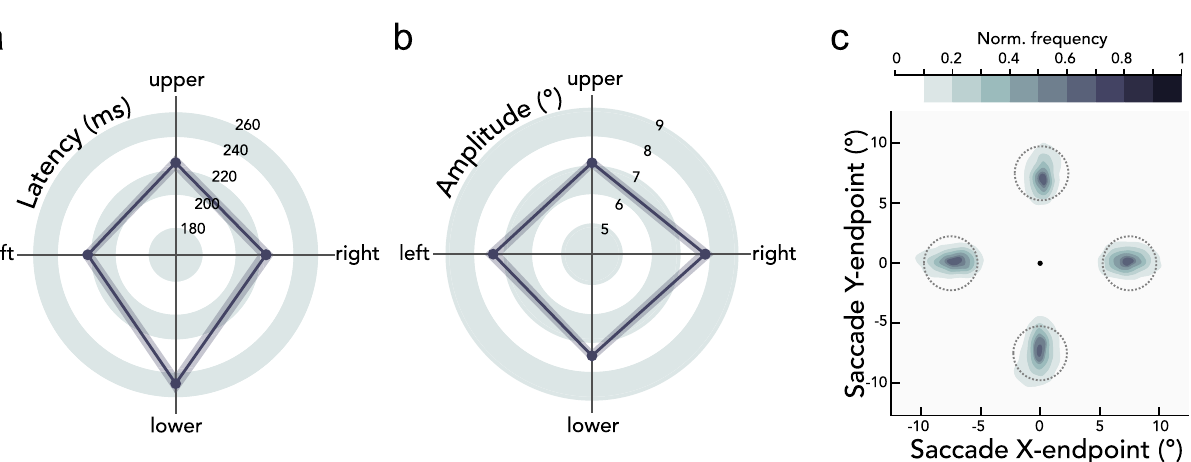
Figure 5. Eye movement parameters. Group average (a) saccade latencies (ms) and (b) saccade amplitudes (°) as a function of saccade direction. Shaded error areas indicate ± 1 SEM. (c) Normalized saccade endpoint frequency maps averaged across participants as a function of saccade direction. Dashed gray circles indicate the 2.25° saccade target region. The black circle in the center indicates the fixation